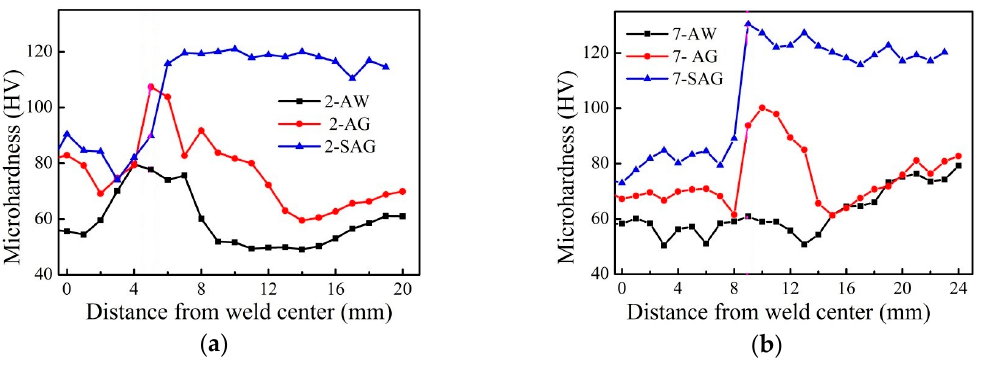
Figure 13. Microhardness distributions across the welded joints with different types of PWHTs: ( a ) welded joint No. 2; ( b ) welded joint No. 7.